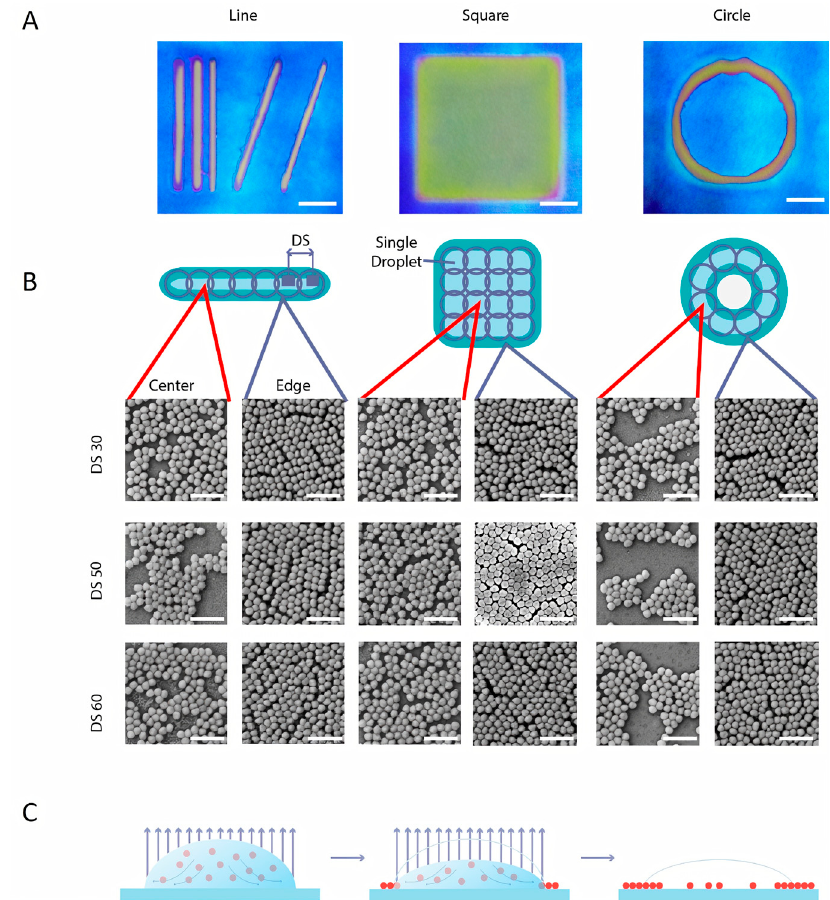
Figure 3. ( A ) The images of 3 types of printed patterns. Scale bar: 1 mm. ( B ) SEM images of PS ordering in the center and on the edge of the droplet in the printed forms with different drop spacings (DSs). Scale bar: 500 nm. ( C ) The distribution of matter in a drop by taking into account the Marangoni effect.